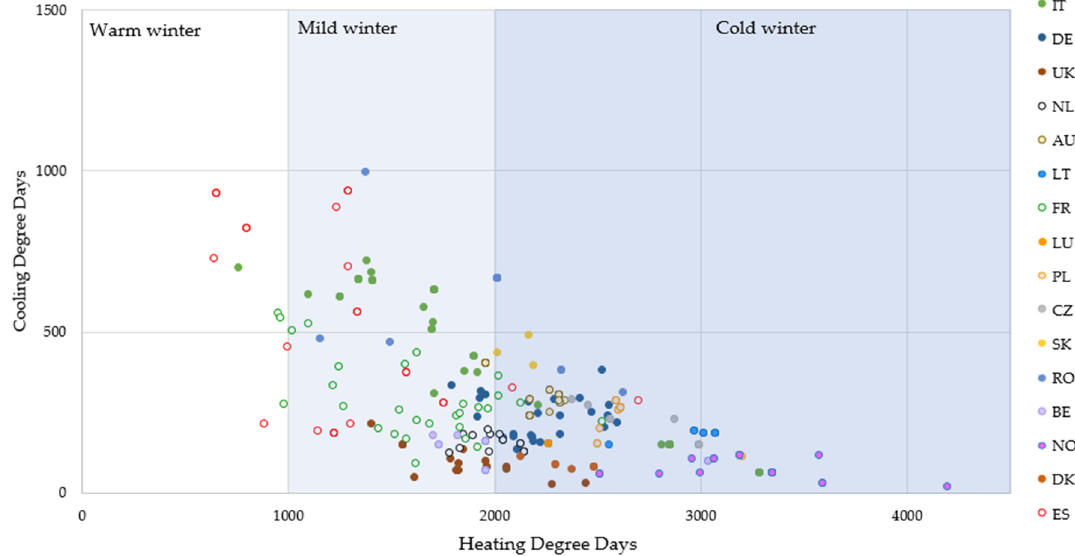
Figure 1. Classification of nZEBs by countries, according to HDD (15 °C) and CDD (18.5 °C). Definition of three winter rigidity levels (warm HDD15 < 1000; mild 1000 ≤ HDD15 < 2000 and cold HDD ≥ 2000). Note: one point can include more than one building, because one point represents a location.